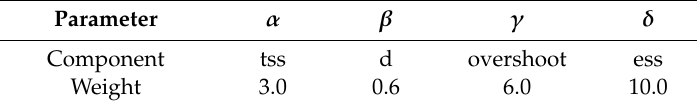
Table 3. Weights assigned to each regulator performance